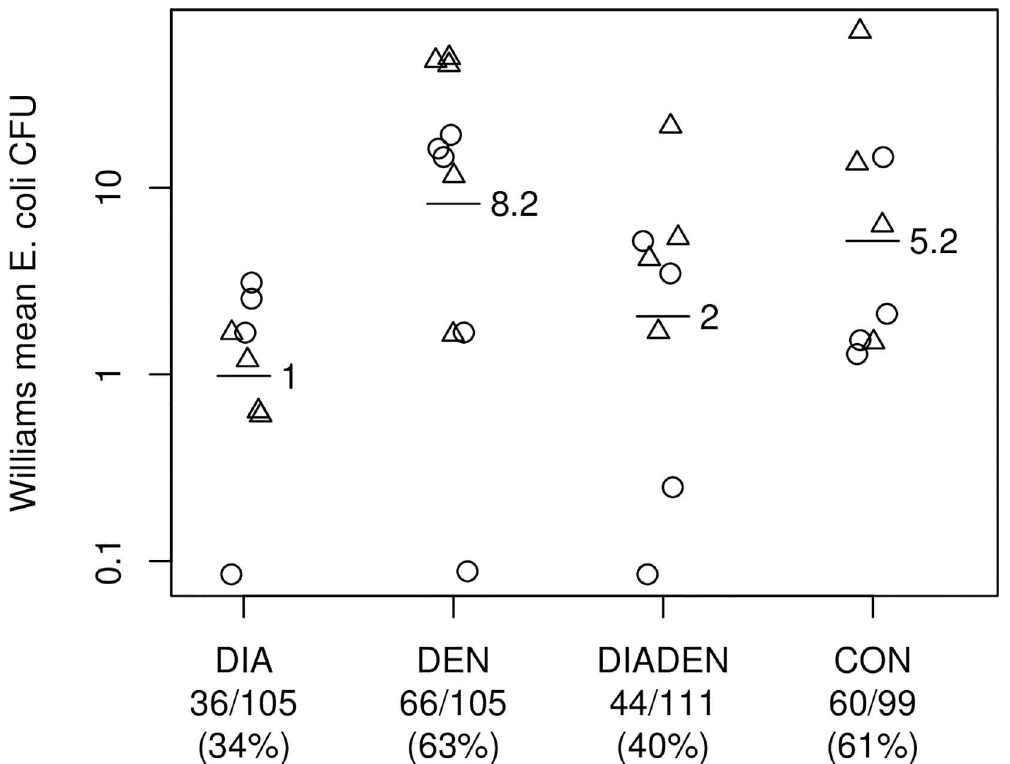
Fig 4. Effect of interventions on water quality. Mean E . coli concentration in drinking water storagecontainers, taps andwater filters (horizontal bars with number)in rural primaryschoolsin four arms receiving either diarrhea (DIA), dengue(DEN), both (DIADEN), or no intervention(CON). Each plot symbol is one school(circles= Anapoima, triangles= La Mesa). Numbersbelowgraph show no. of E . coli positive containers/no. of sampledcontainers (percentpositive containers). The diarrheainterventions reducedthe Williamsmean colonyformingunits (CFU) by 78% (ratio 0.22, 95%confidenceinterval0.07–0.65, p = 0.008).